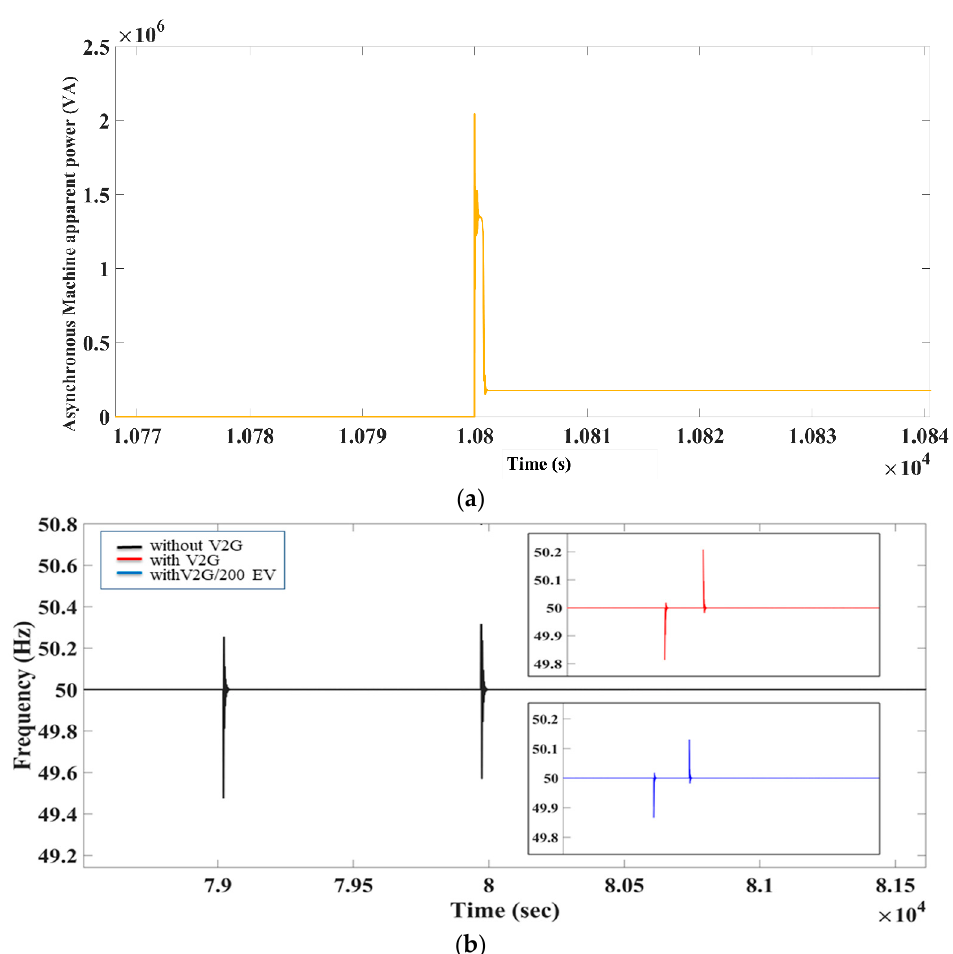
Figure 9. Starting of asynchronous machine. ( a ) Apparent power and ( b ) frequency regulation for three different cases.